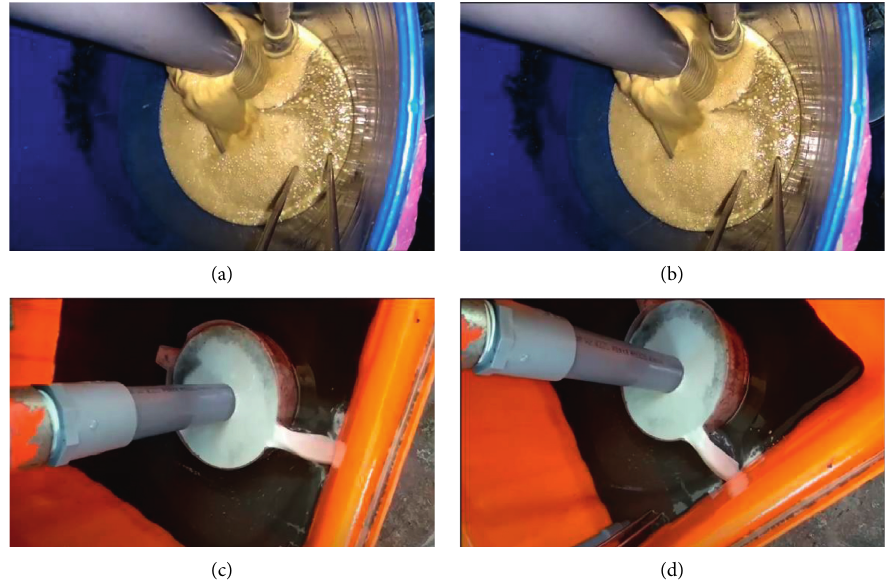
Figure 8: Emulsion pumping station is higher than when using pneumatic rock drill (from Google: https://www.youtube.com/watch? v � xFVJly6ViSo).